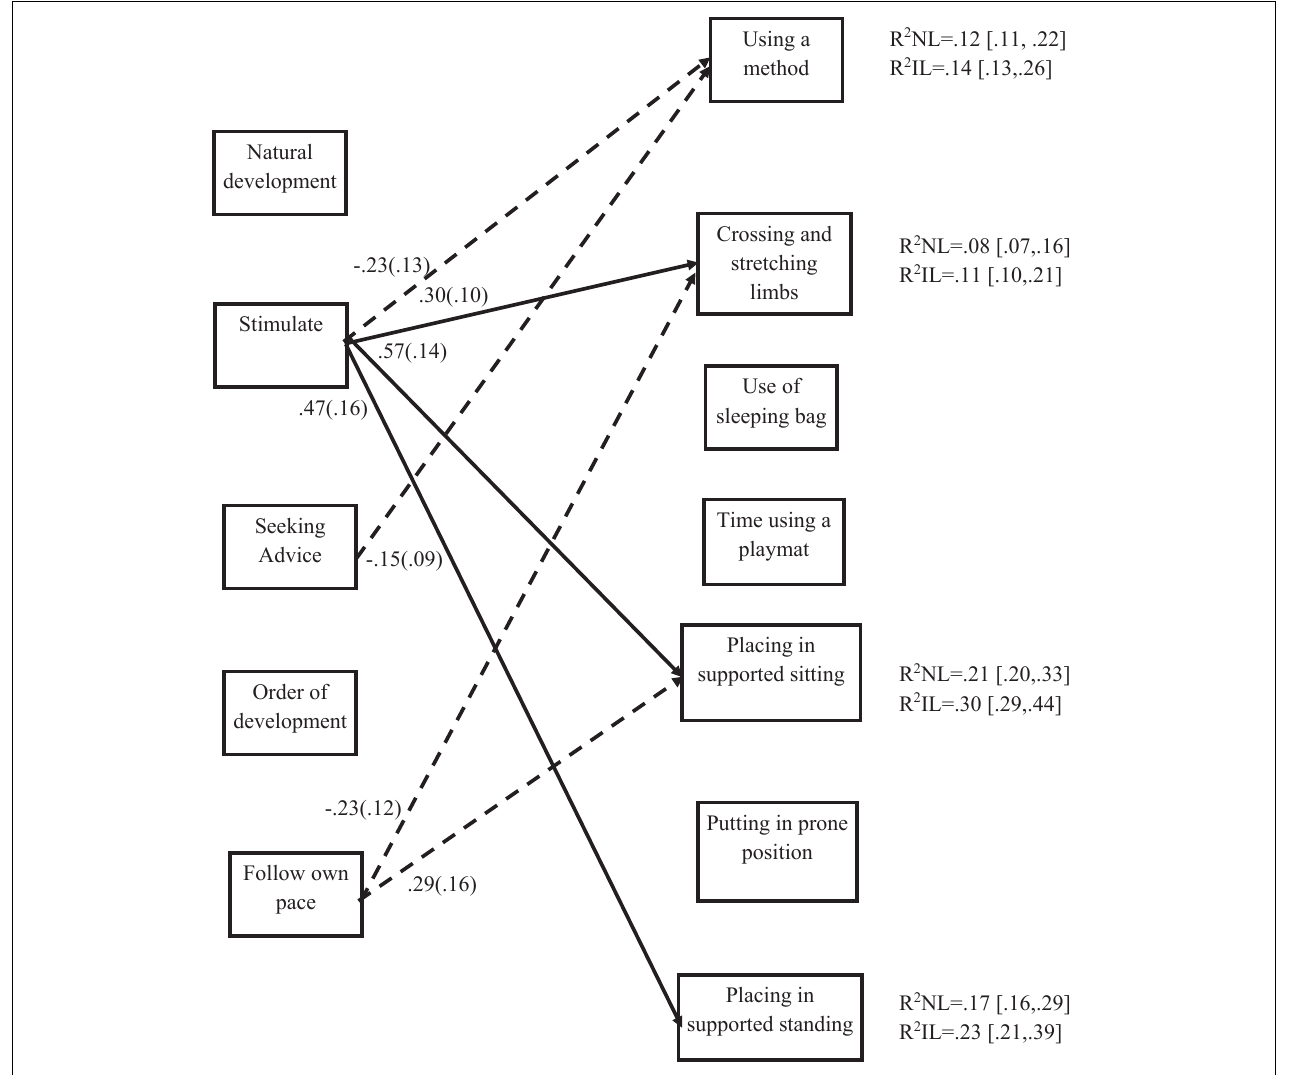
FIGURE 1 | Results of SEM for predictions of practices by beliefs. Only significant paths are presented. Dashed lines are paths significant at the level of p < 0.10. Unstandardized path coefficients are reported with the standard error. For simplicity reasons, paths to control variables are not presented. Next to each R 2 -value the confidence interval is